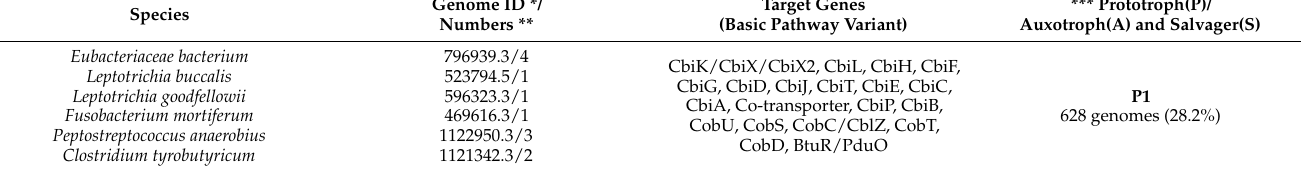
Table A1. Distribution of cobalamin/B12-related pathways in human gut microbial genomes according to Rodionov et al. [12].